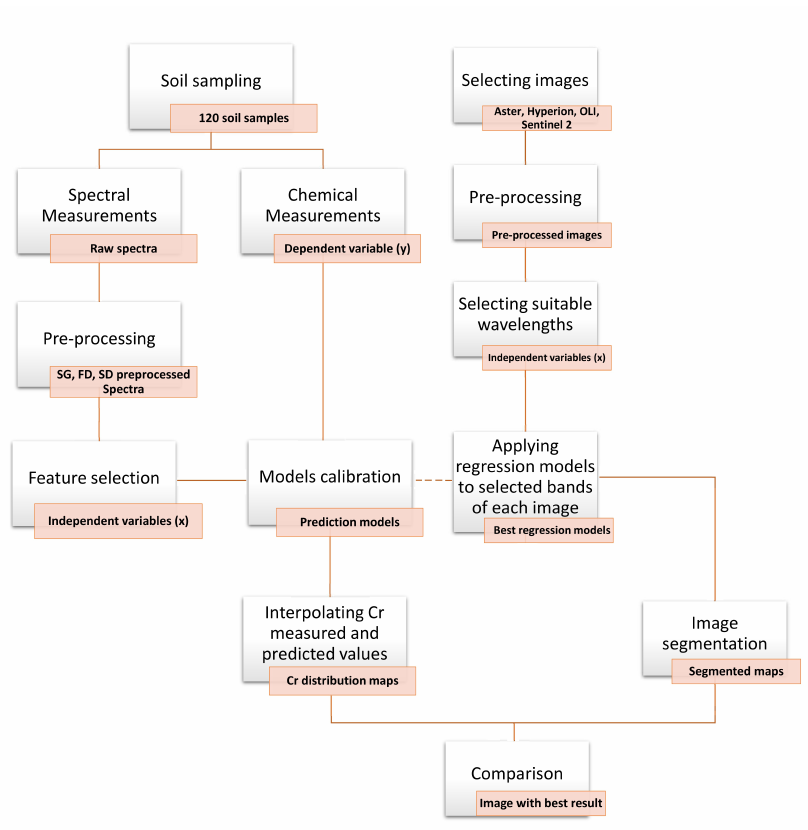
Figure 2. Flowchart of the procedure applied in this study.